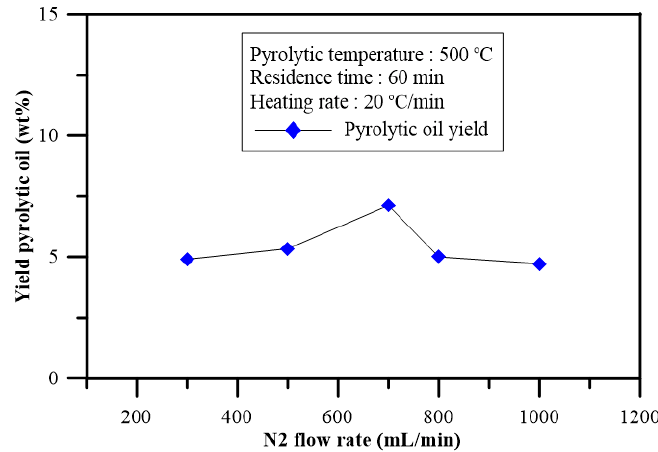
Figure 4. The effect of nitrogen flow rate on the yield of pyrolytic oil.